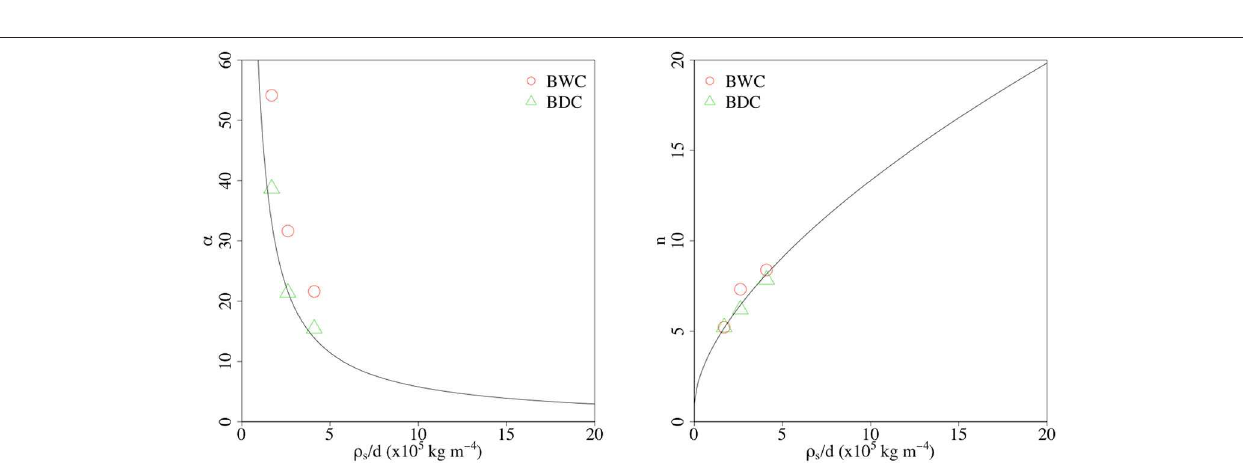
Frontiers in Earth Science |